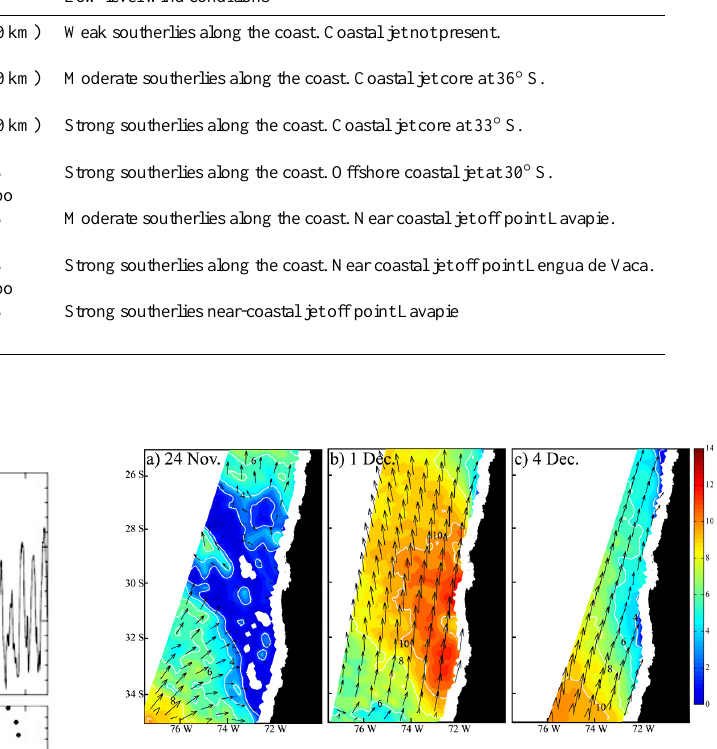
Fig. 5. ASCAT-derived surface wind speed (colours, common scale at right in ms − 1 ) and wind vectors (arrows) at 15:00UTC (11:00LT) of (a) 24 November, (b) 1 December and (c) 4 Decem- ber